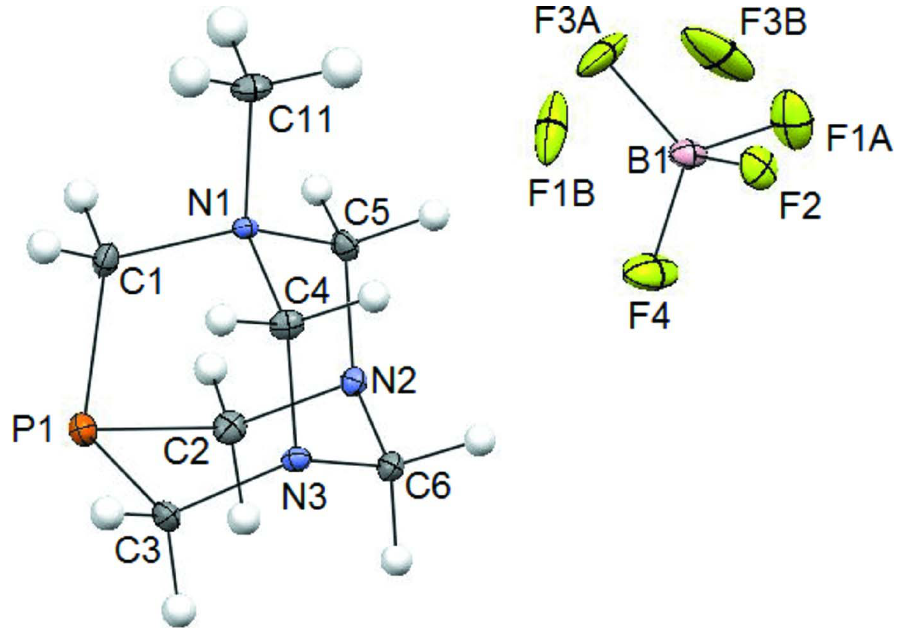
The molecular structure of (I) with displacement ellipsoids drawn at the 20% probability level. H atoms are represented as spheres of arbitrary radius. The disordered F1 and F3 atoms are shown over their two